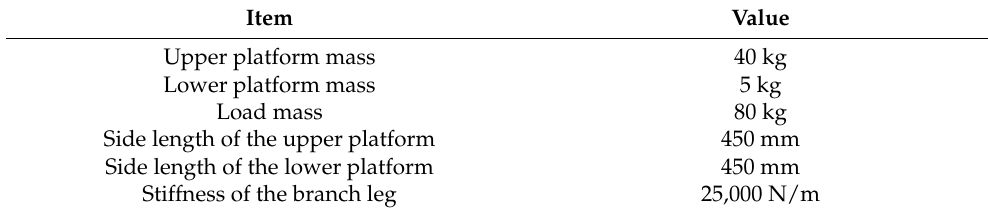
Figure 11. Virtual prototype model of the cubic Stewart parallel mechanism. Table 2. Virtual prototype model parameters.